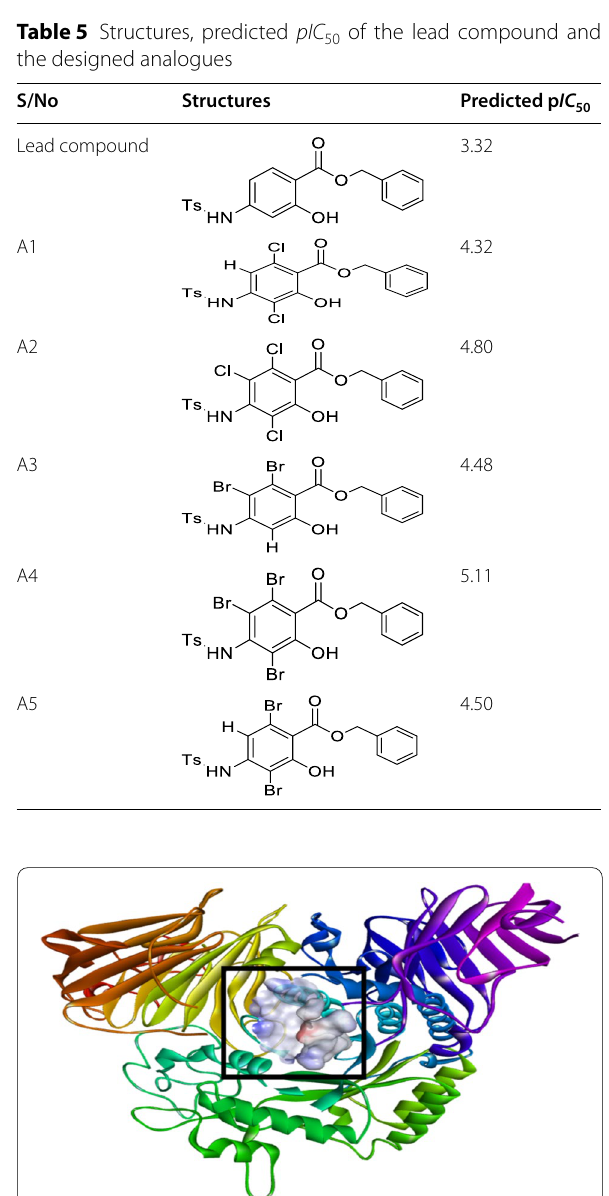
of the lead compound and 50